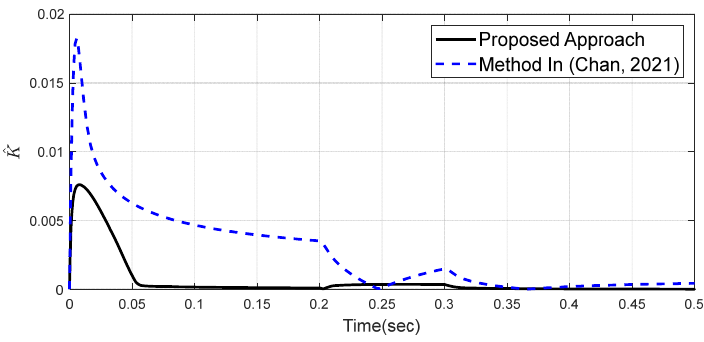
Figure 18. Adaptation gains [1] .